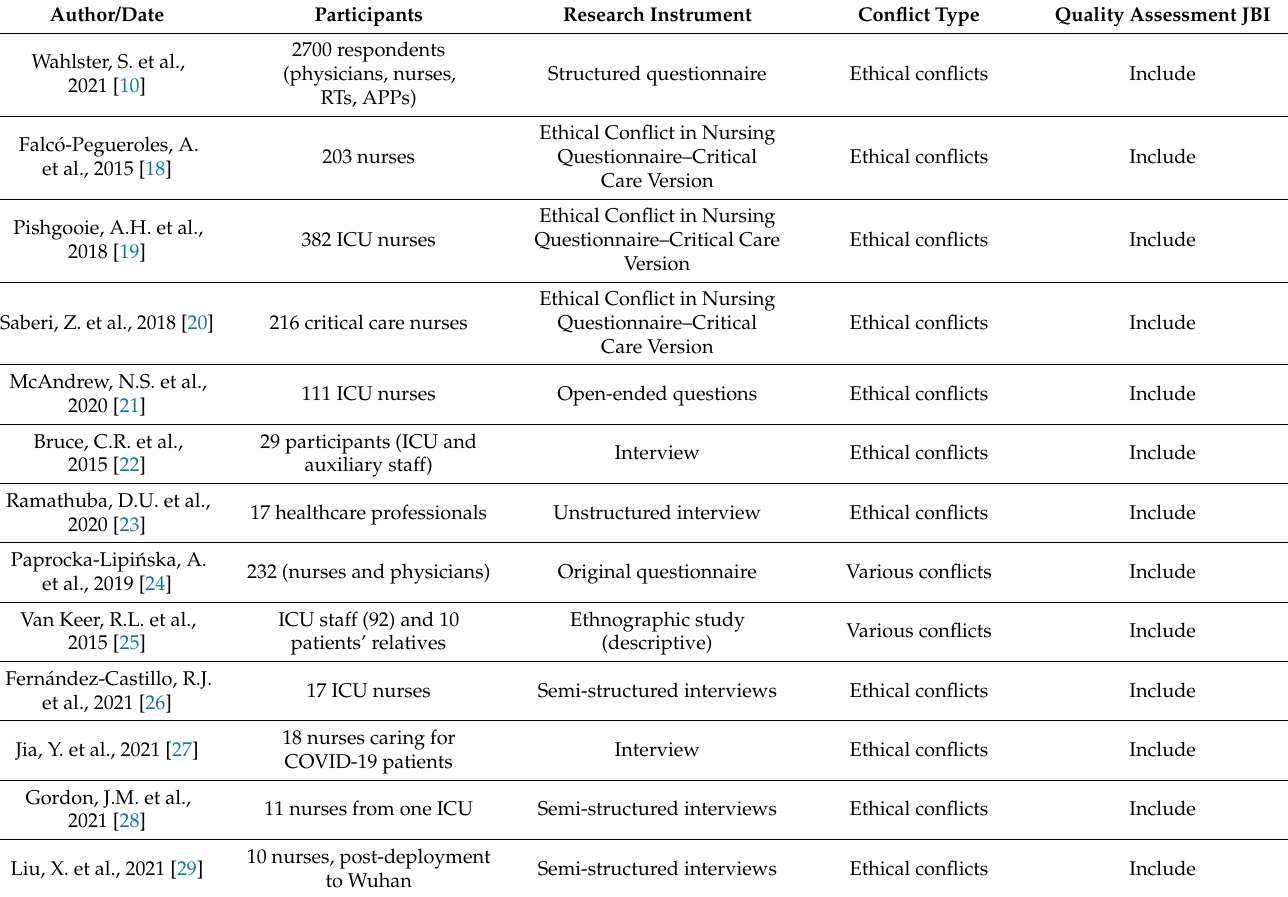
Table 2. Quality assessment using the Joanna Briggs Institute (JBI) Critical Appraisal Checklist for Cross Sectional Studies/Qualitative